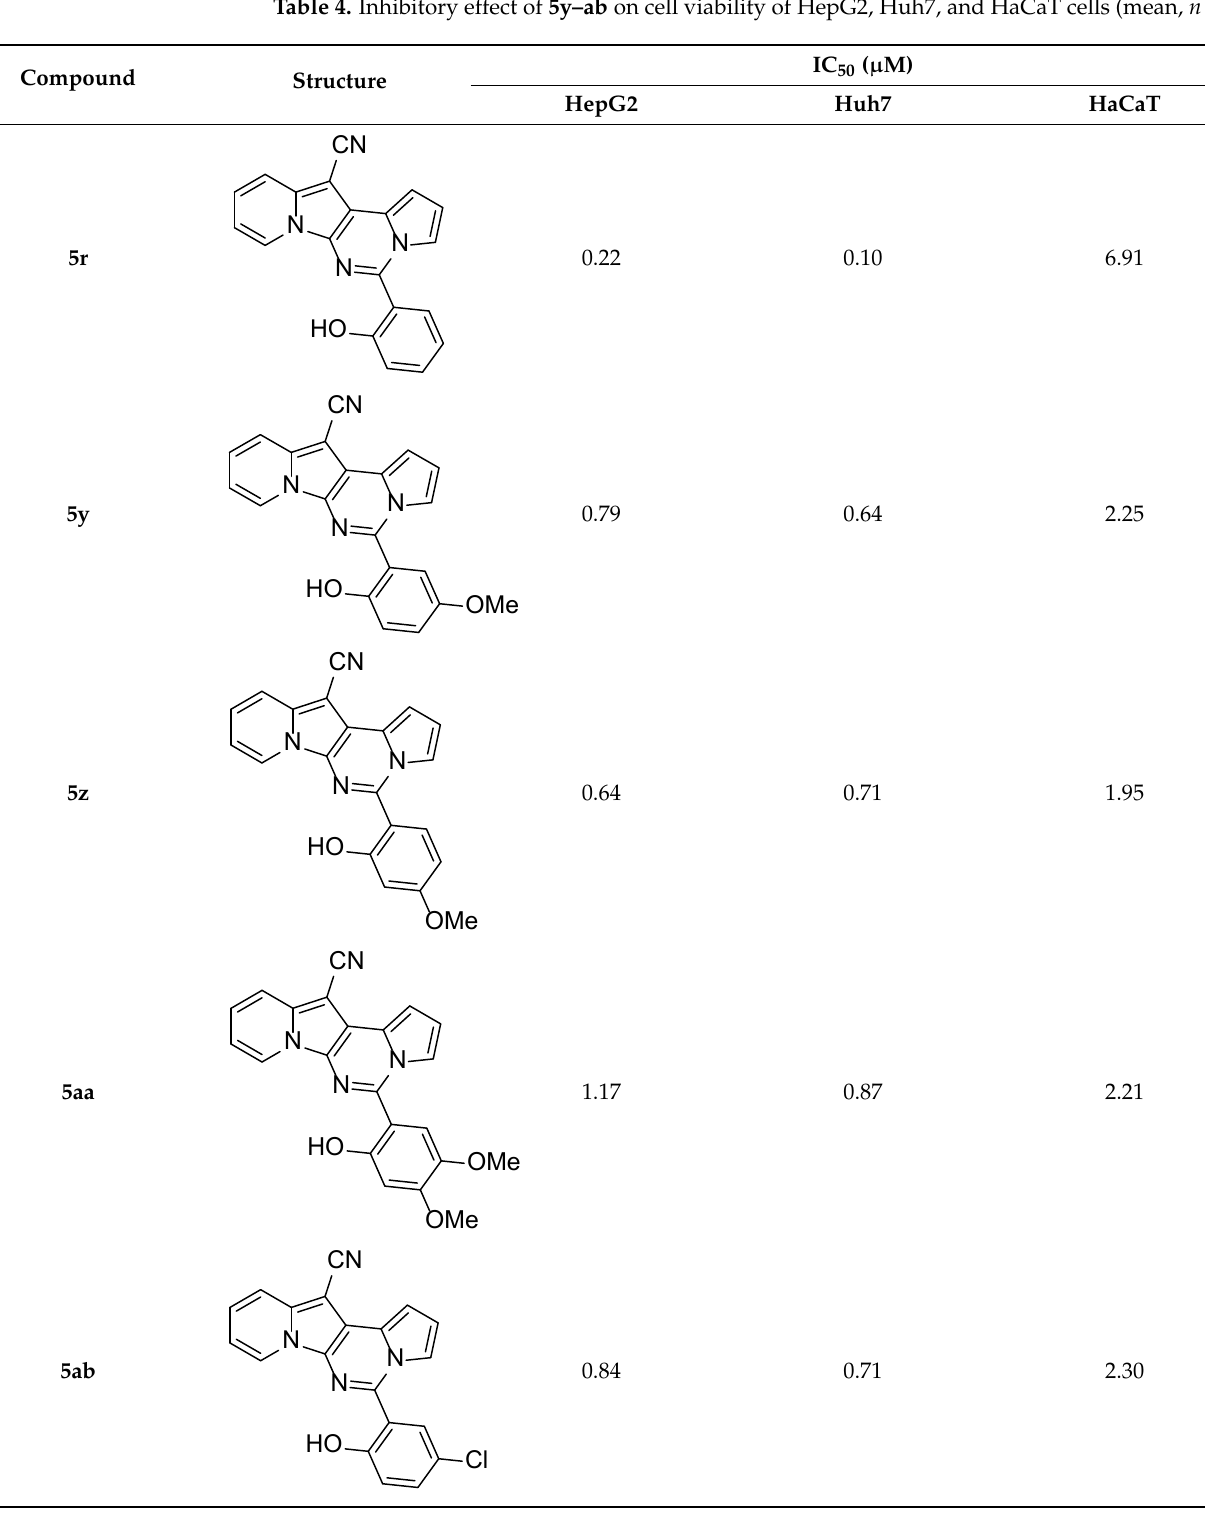
Table 4. Inhibitory effect of 5y–ab on cell viability of HepG2, Huh7, and HaCaT cells (mean, n = 5).